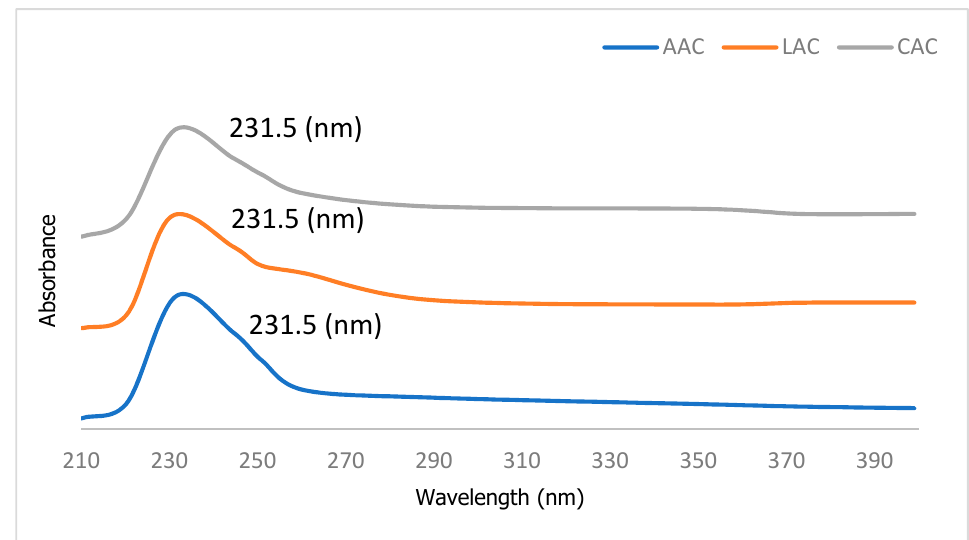
Figure 1. UV absorption of needlefish skin collagens extracted with different acids. AAC: acetic acid collagen; LAC: lactic acid collagen; CAC: citric acid collagen.